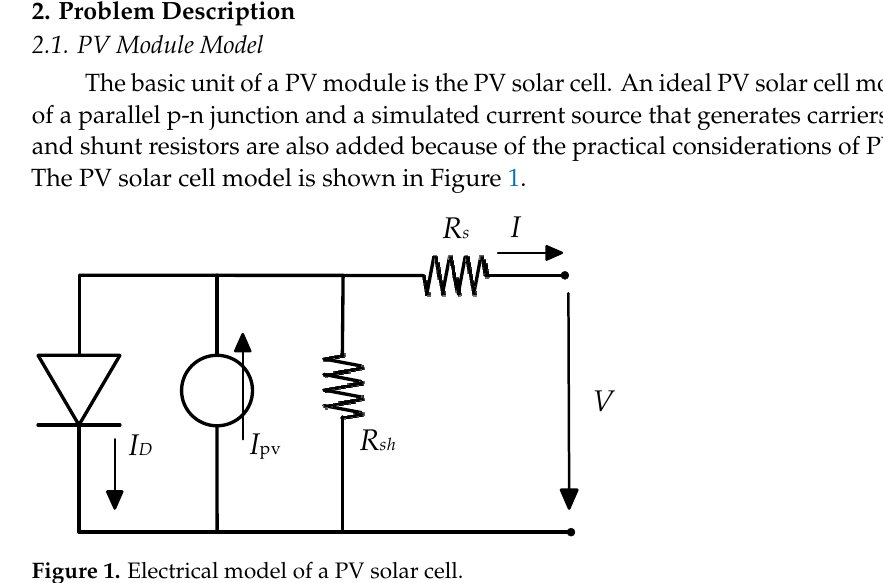
Figure 1. Electrical model of a PV solar cell.